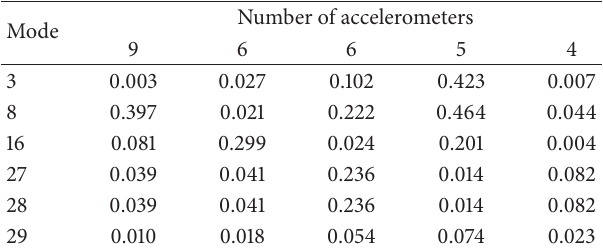
Table 9: The MAC values of acceleration damage parameter in Z transitional direction.